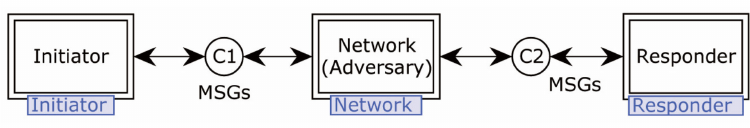
Figure 5. Protocol top-level CPN model.